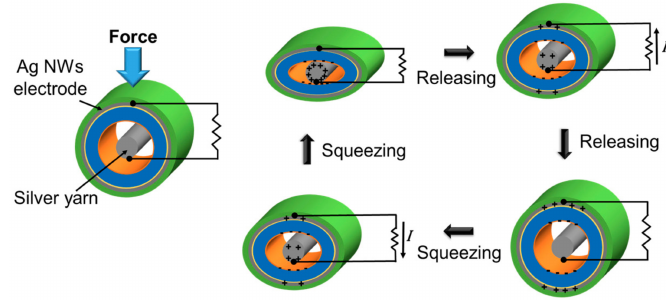
Figure 2. Cross-sectional view of the device to explain energy-harvesting operation during repetitive contact-separation